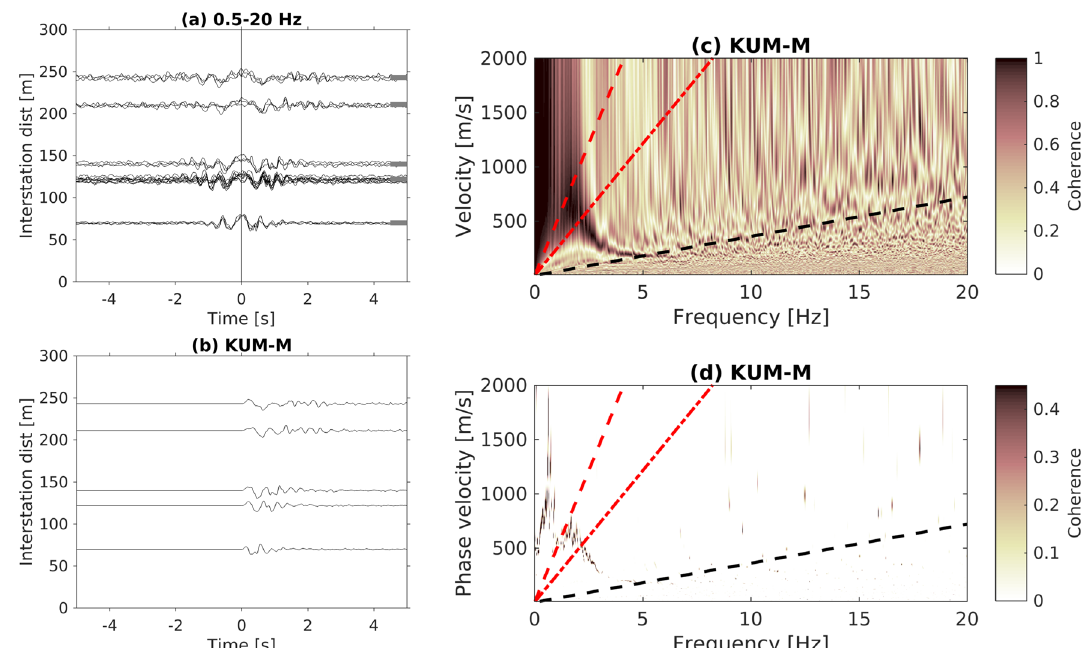
Fig. 1 Ambient noise correlations. a Cross-correlations signals of the KUM-M array. b Binned and symmetrized cross-correlations. c Dispersion image from the data in b calculated with the (low-resolution) Radon transform. d The same as in c but calculated using the deblurring technique (Mikesell, et al. 2017). In c and d, the resolution and aliasing limits are shown by dotted and dashed straight lines,